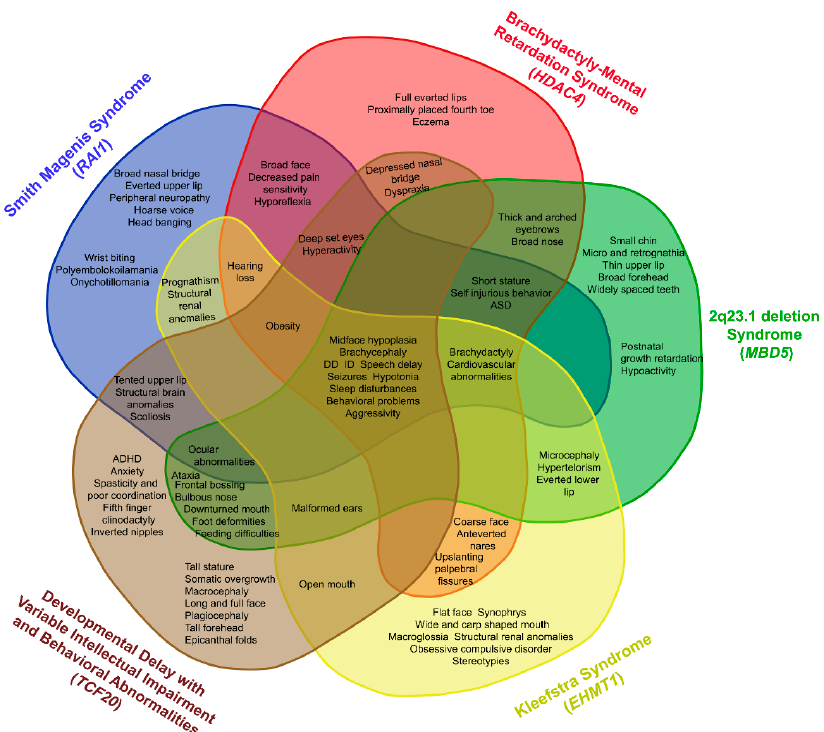
Figure 3. Venn diagram showing common and specific clinical features of SMS-overlapping disorders (2q23.1 deletion, BDMR, KS, and DDVIBA). ID—intellectual disability, DD—developmental delay, ASD—autism spectrum disorder.